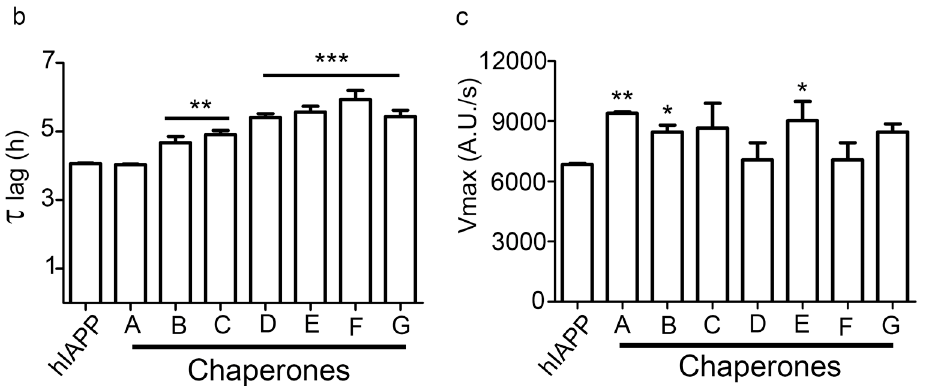
Figure 5. Kinetics, ν max and τ lag in hIAPP 1–37 aggregation incubated with the chaperones A , B , C , D , E , and G at 37 °C. All data corresponds to equimolar relation between hIAPP 1–37 and each pharmaco-chaperone (12.8 µmol/L). ( a ) The kinetics adjust to a sigmoidal curve. hIAPP 1–37 only = red line, chaperone A = blue line, chaperone B = green line, chaperon C = orange line, chaperone D turquoise line, chaperon E = black line, Chaperon G = pink line. Chaperone F not shown; ( b ) Phase lag in hIAPP 1–37 aggregation and fibril formation reached by the chaperones A , B , C , D , E and G . All chaperones reveal a superior time compared to hIAPP 1–37 , except chaperone A ; ( c ) Vmax in hIAPP 1–37 aggregation and fibril formation were reached by the chaperones A , B , C , D , E and G . * p < 0.05, ** p < 0.01, *** p < 0.001 when compared with hIAPP 1–37 condition only as control. One-way ANOVA and post-hoc Newman–Keuls Multiple Comparison Test.